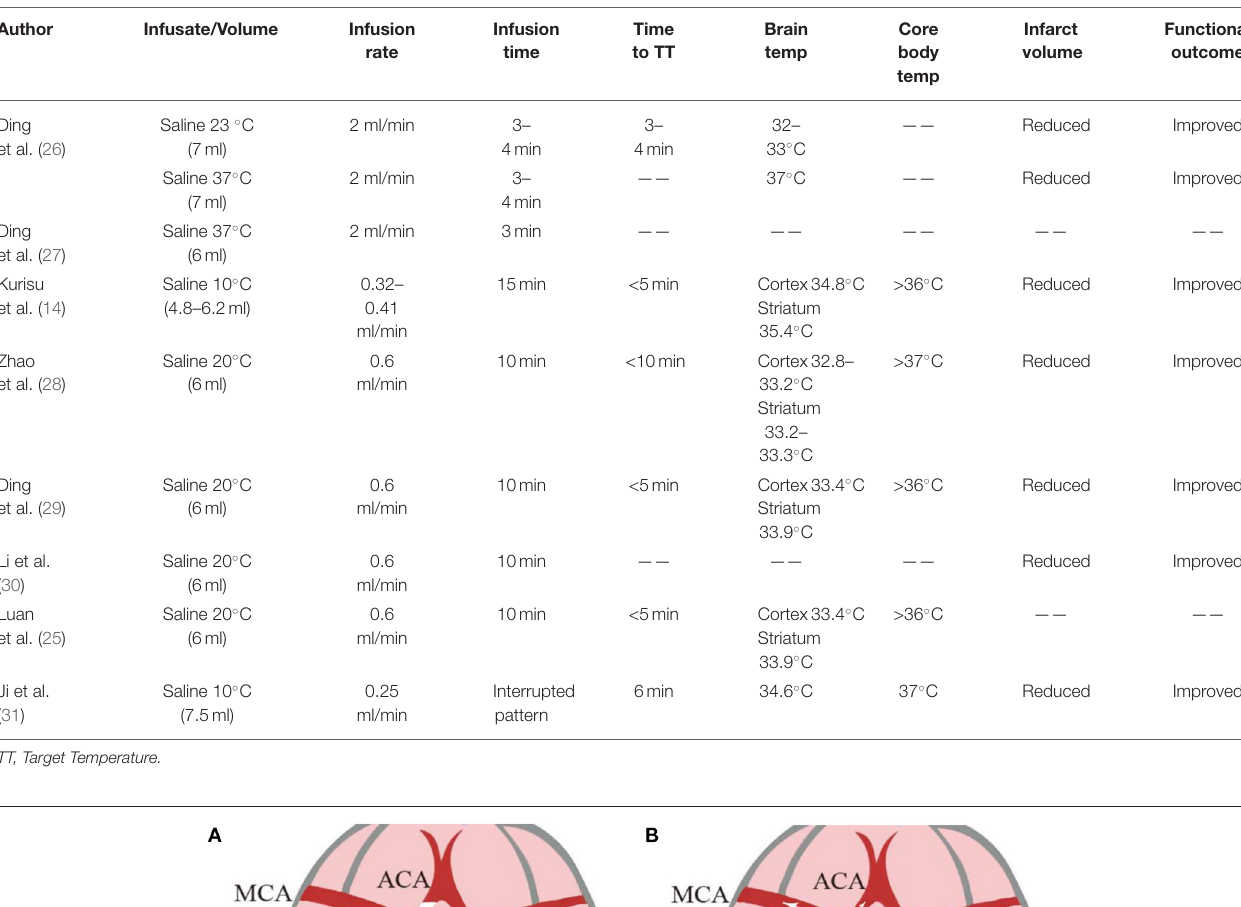
TABLE 1 | Studies on rodents.